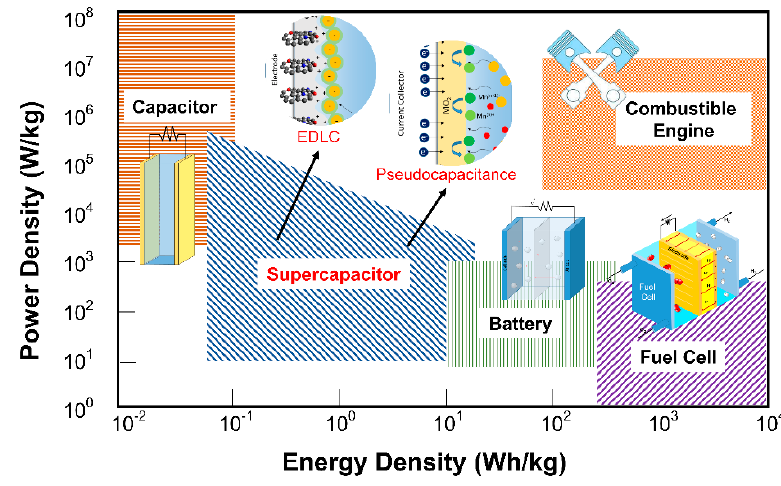
Figure 1. Ragone plot for several types of electrochemical energy storage devices: adapted from Reference [5]. Copyright American Chemical Society, 2004.